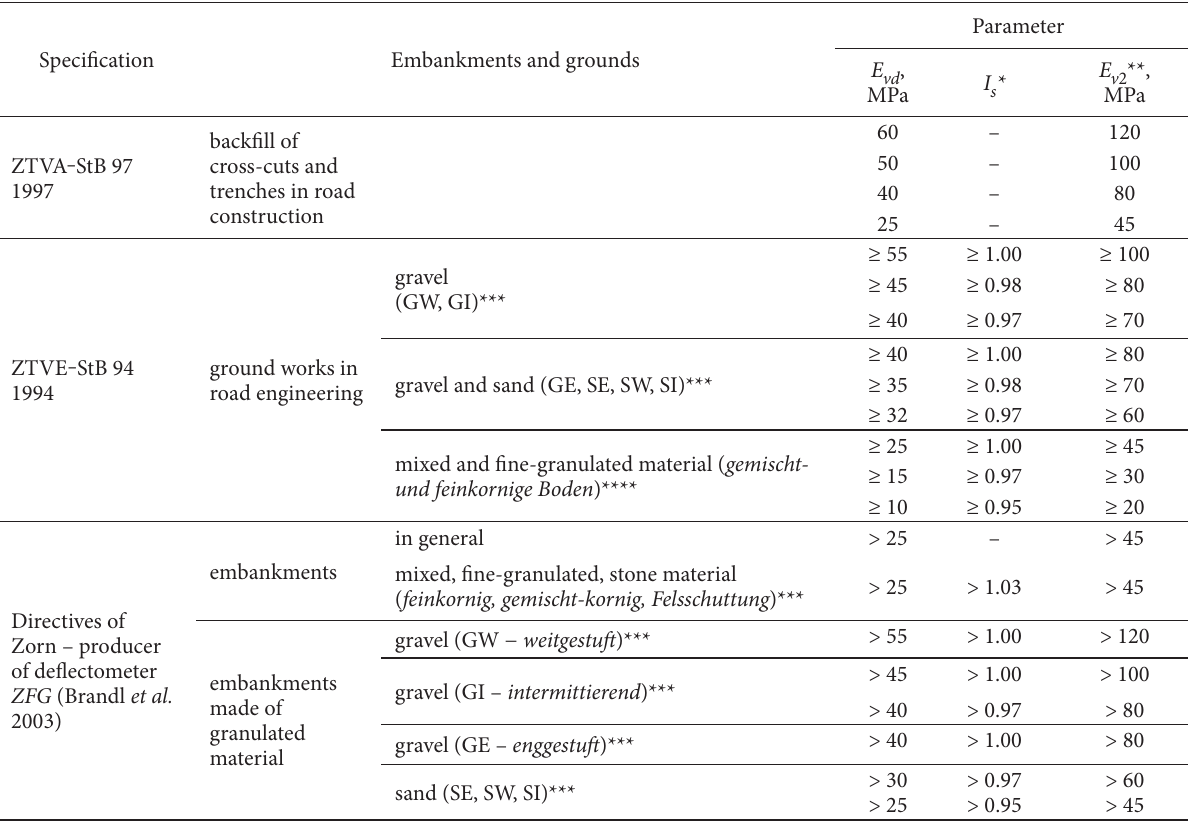
Table 2. List of approximate limit values of E vd according to German specifications